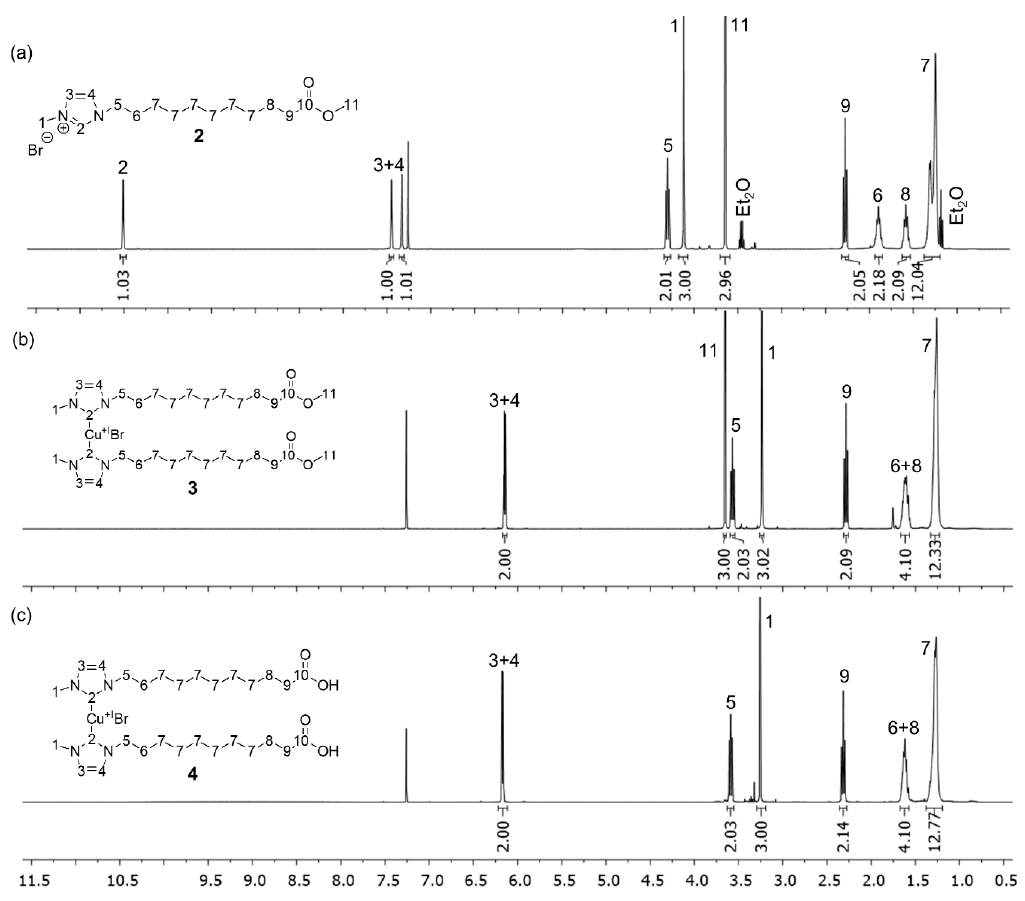
Figure 2. 1 H NMR spectra of ( a ) the NHC precursor 2 , ( b ) the methyl ester protected complex 3, and ( c ) the deprotected complex 4 bearing two carboxyl groups.